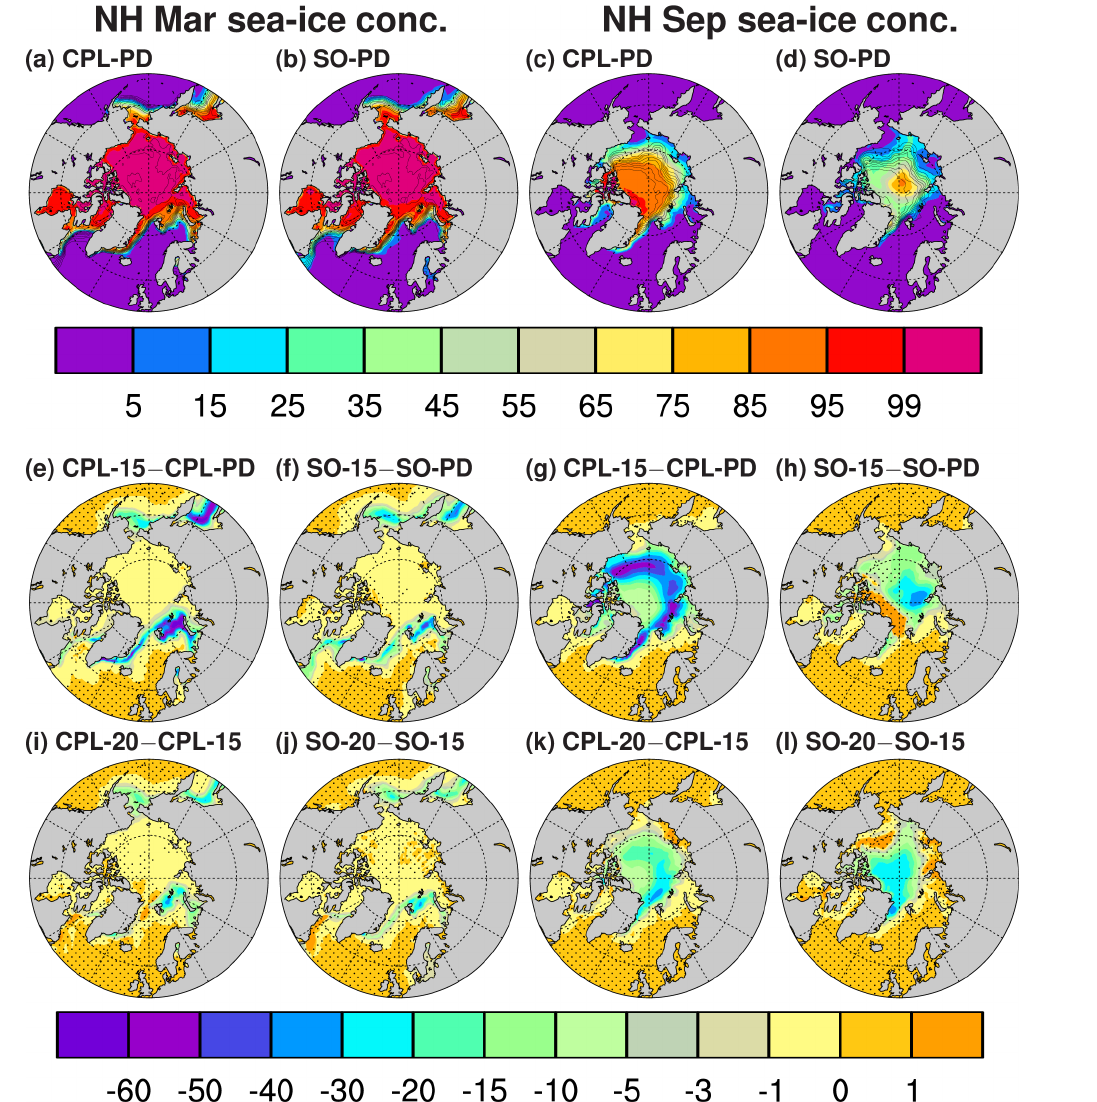
Figure 19. NH monthly-mean sea-ice concentrations for PD (a–d) , the 1.5 ◦ C warming relative to PD (e–h) , and the 0.5 ◦ C warming (i–l) from NorESM1-Happi (a, c, e, g, i, k) and NorESM1-HappiSO (b, d, f, h, j, l) . Fields are shown for March (a, b, e, f, i, j) and September (c, d, g, h, k, l) . The modelled concentrations are from the default 90-year periods (Sect. 3.2). The PD results (colours; top colour bar) are shown together with observational estimates (OSI-SAF, 2017; solid black contours) from 2006 to 2015. Differences that are not statistically significant at the 5% level according to the Mann–Whitney U test are marked with black dots. Units are percentages of ocean surface area (a–l)